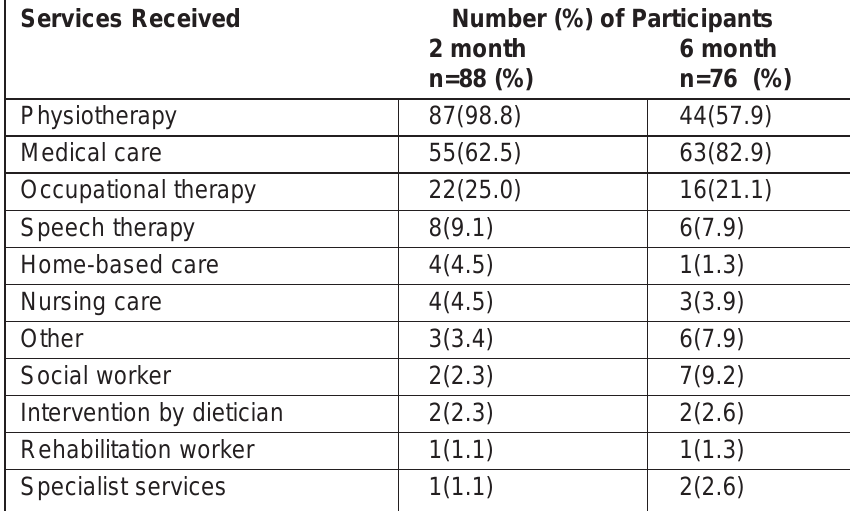
Table 3: Services received by the participants as reported at 2 and 6 months post stroke.